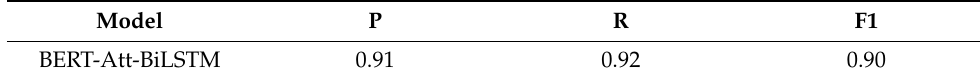
Table 4. Performance of Emotion Classification